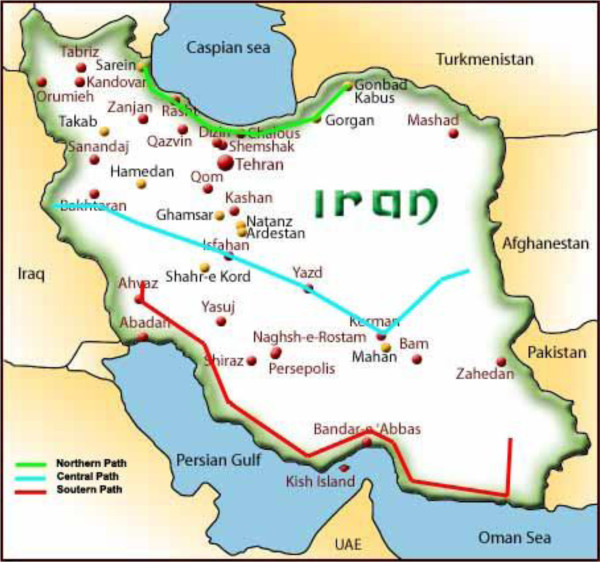
The pathway schema of the selected sampling points in North, South, and Center of Iran.